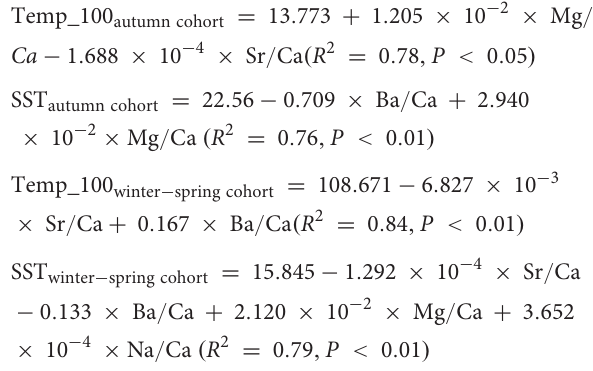
( Figure 4 ). Accordingly with ANOVA results, the ratio of